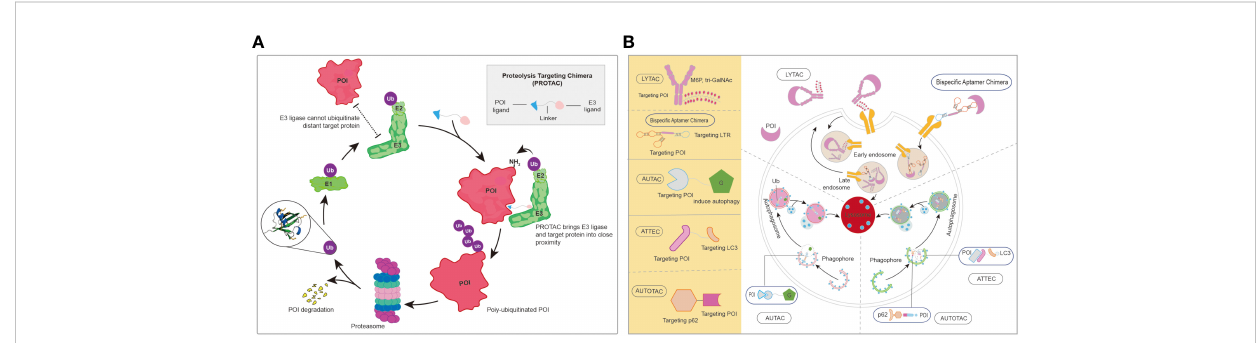
FIGURE 7 (A) The brief mechanism of PROTACs. (B) The representative of protein degradations by lysosome. AUTAC, autophagy-targeting chimera; LYTAC, lysosomal-targeting chimera; PROTAC, proteolysis-targeting chimera. AUTOTAC, Autophagy-targeting chimera; ATTEC, autophagosome-tethering compound; POI, protein of